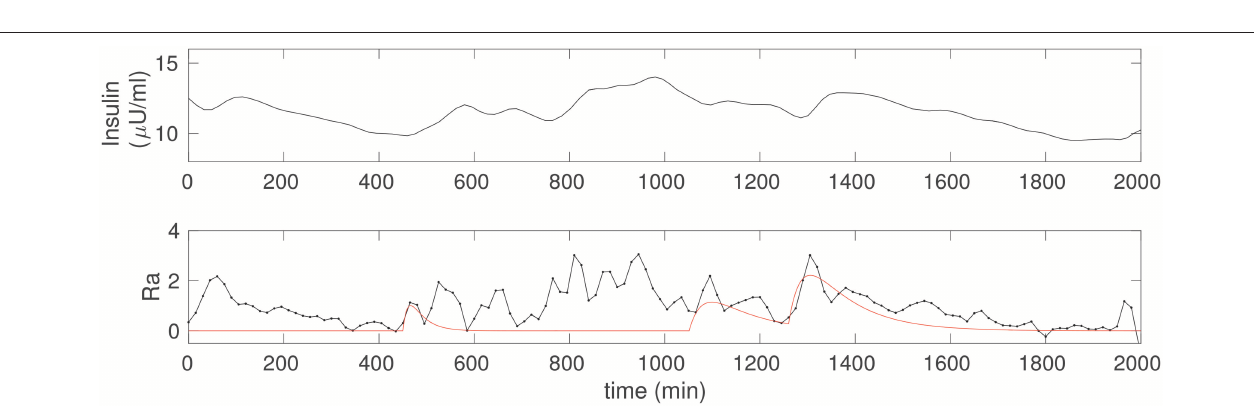
FIGURE 3 | The CGM of about 24 h of a diabetic subject, starting at around 0400 h. The glucose data (red) is overlaid with the model simulation (black). An isolated (liquid) food pulse at 1,200 min in this trace has been fit. EG 0 was set to 2.5 × 10 − 3 , the other parameters were estimated as in the non-diabetic case; see text for details. The fitted q sto amplitude is 230.